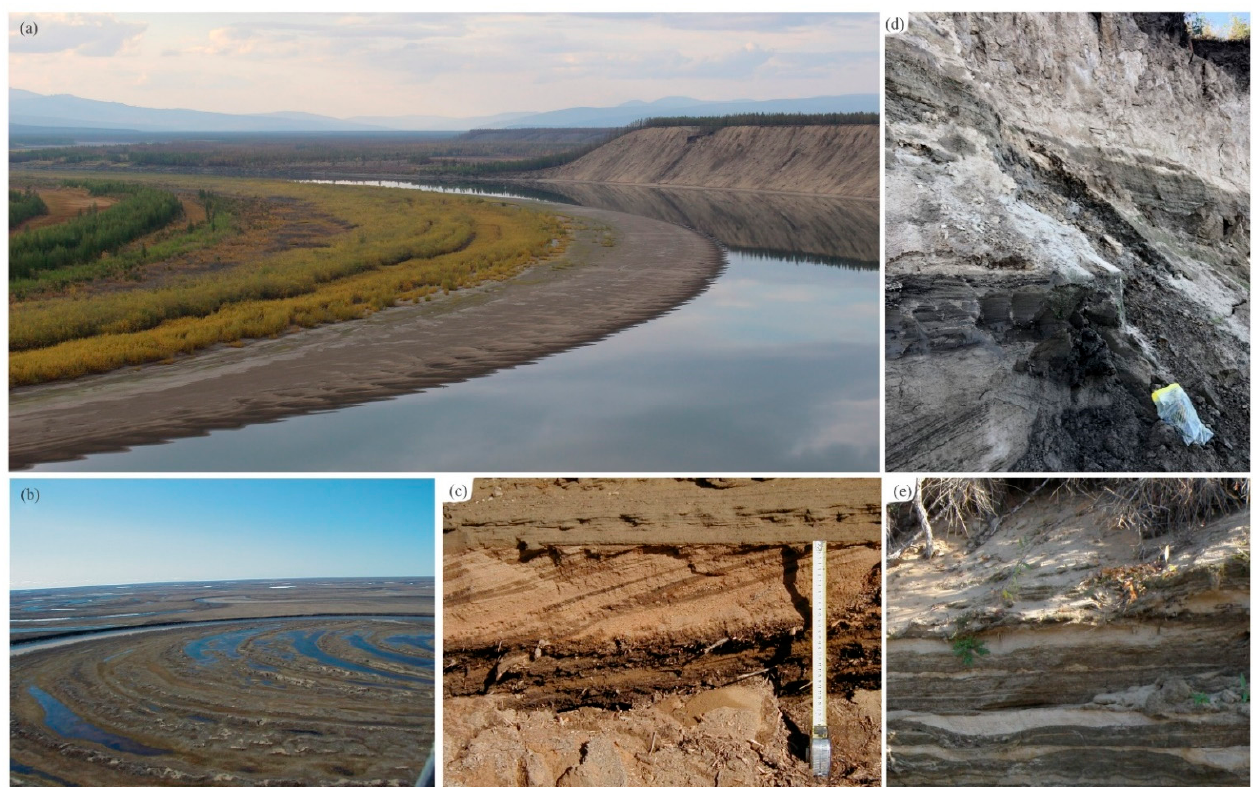
Figure 6. River valleys and alluvial deposit: ( a ) Adycha, Yakutia in September 2019; riverbed is partly exposed, ( b ) Titaluk, North Slope of Alaska, in May 2003; water level is high, floodplain is partly flooded, ( c ) Pleistocene alluvial deposit at the Titaluk River with plant debris and numerous insects, ( d , e ) young floodplain deposit at the Lena River.